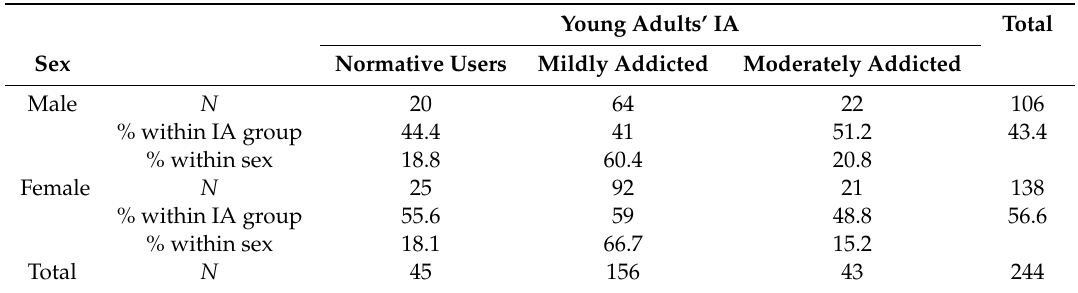
Table 2. Association between young adults’ gender and internet addiction (IA).